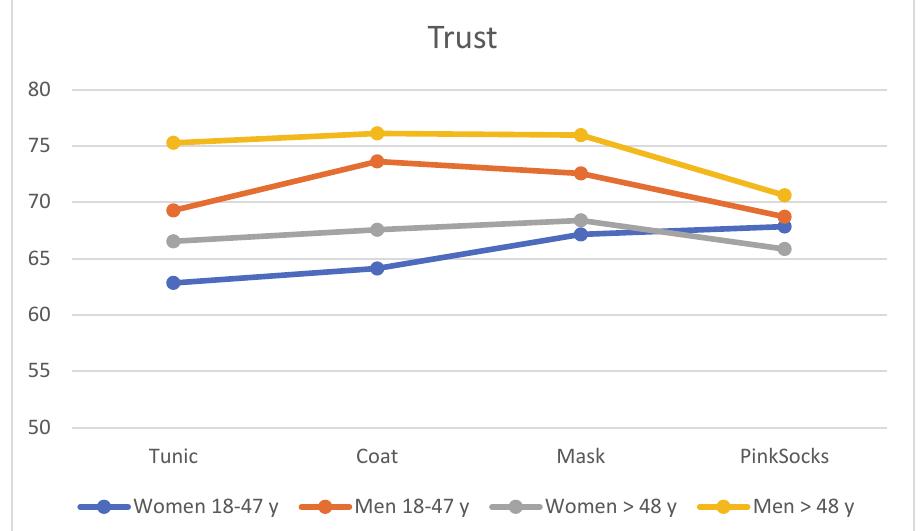
Figure 5. Mean rating of the four photos for trust by the four subgroups ( n = 906).